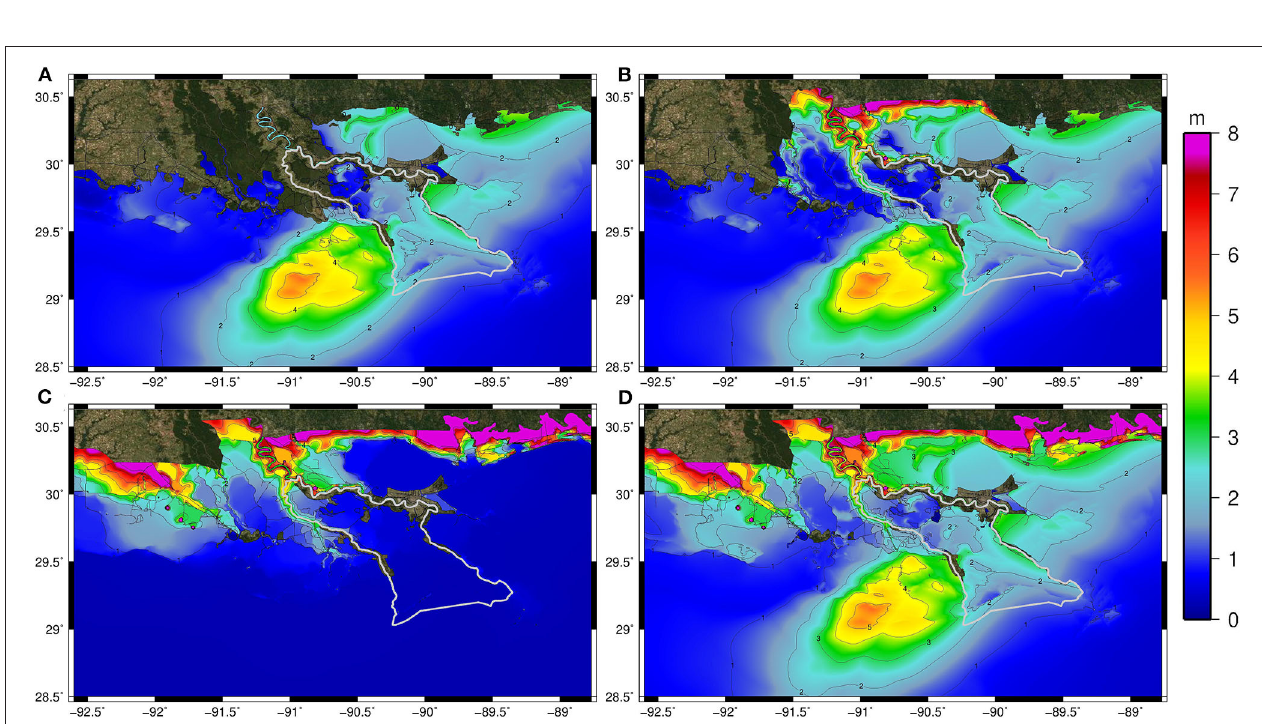
FIGURE 7 | Maximum of maximums (MOM) simulated peak water levels (m, NAVD88) for the Barataria watershed medium event synthetic storms for (A) storm surge only (no rainfall), (B) storm surge and TC-driven rain, (C) antecedent rainfall only (no storm surge), and (D) antecedent rainfall, TC-driven rainfall, and storm surge in a single